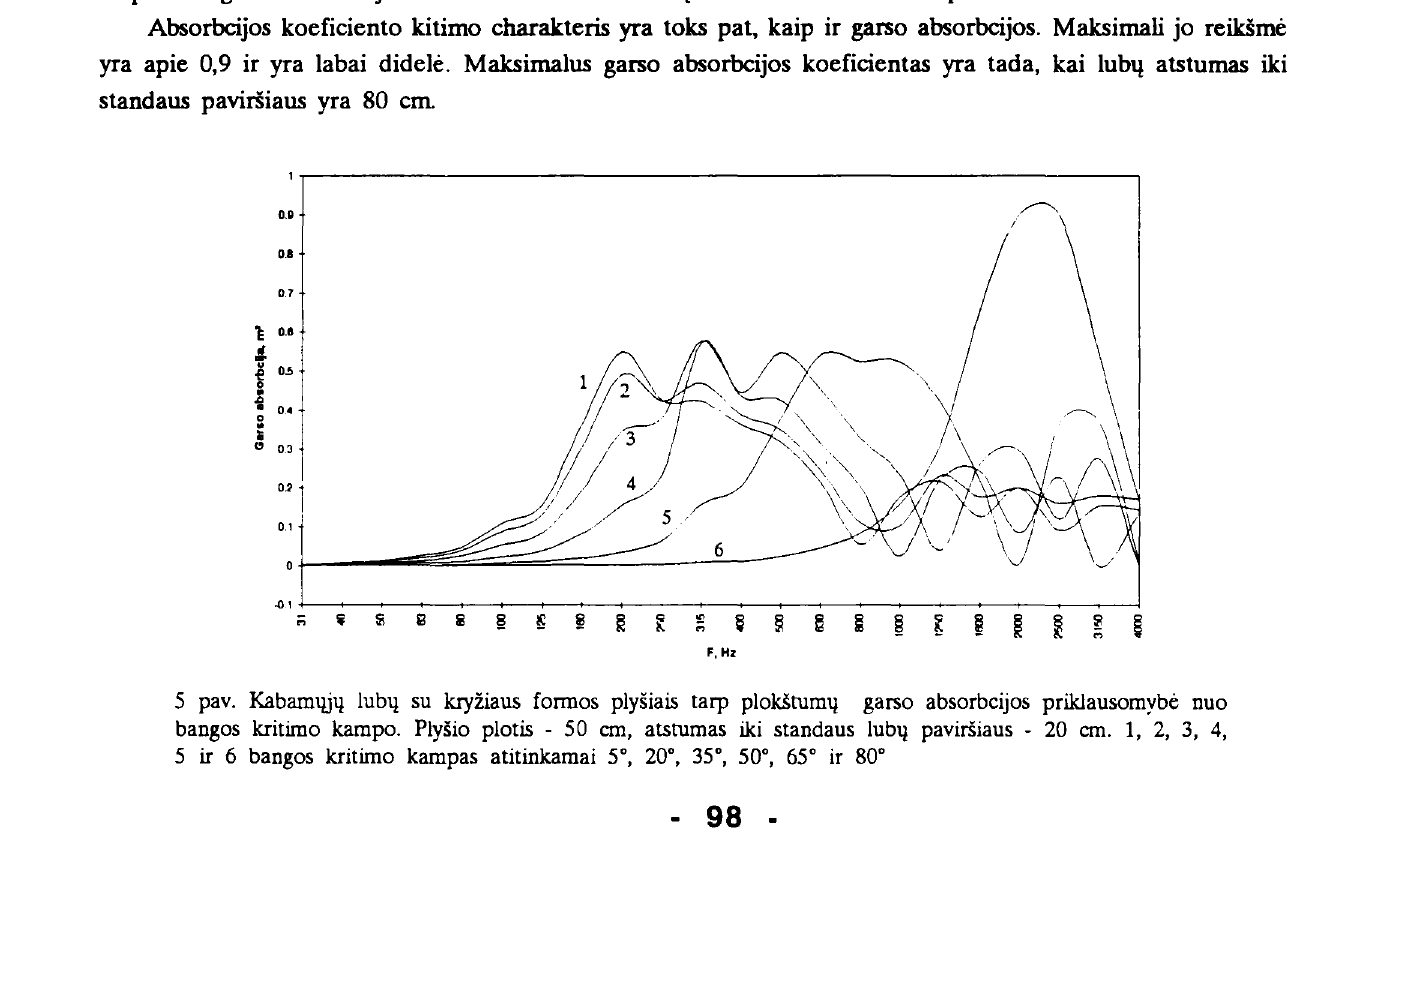
5 pav. Kabam~ll lubl! su kryziaus fonnos plysiais tarp plokStuml! garso absorbcijos priklausomybe Duo baDgos kritimo kampo. Plysio plotis - 50 em, atstumas iki standaus lubll paviriiiaus - 20 em. 1, 2, 3,